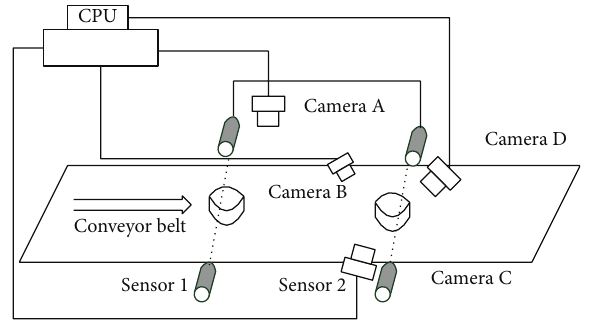
Figure 3: The model of the